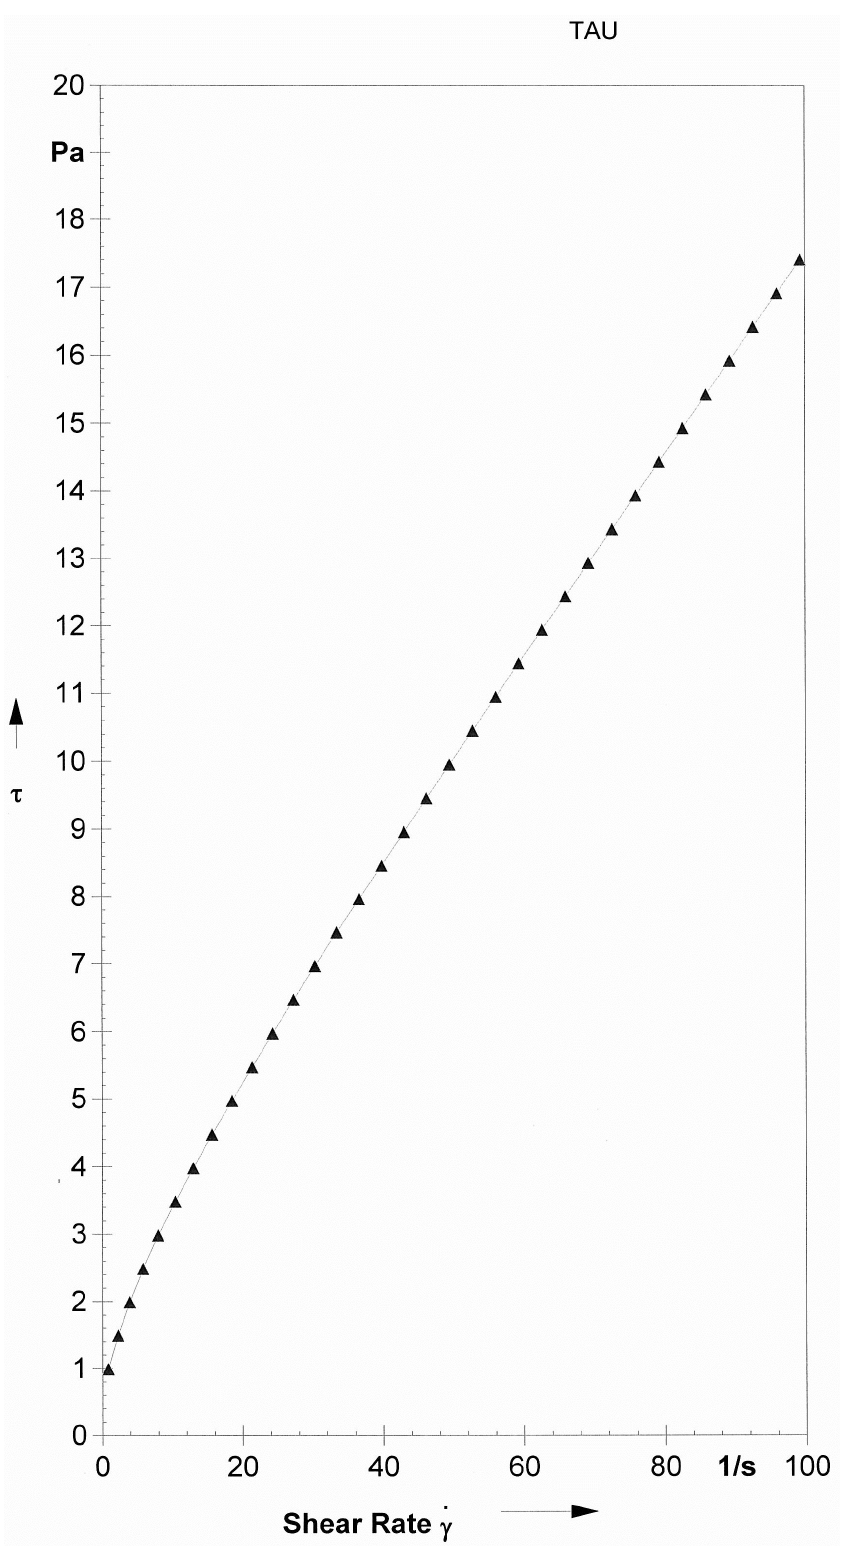
Fig 5. Newtonian rheological of triester. The relation between the shear stress ( τ ) and shear. rate ( γ ).